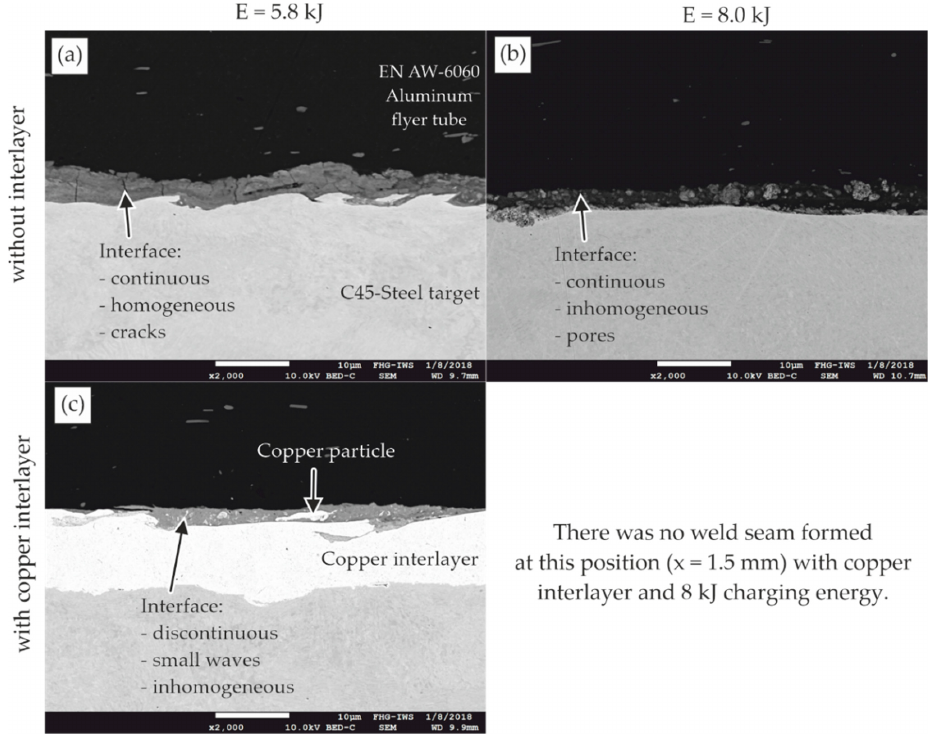
Figure 7. SEM micrographs of the weld seam start at x = 1.5 mm: ( a , b ) without and ( c ) with copper interlayer, magnetic pulse welded at two different energy levels.